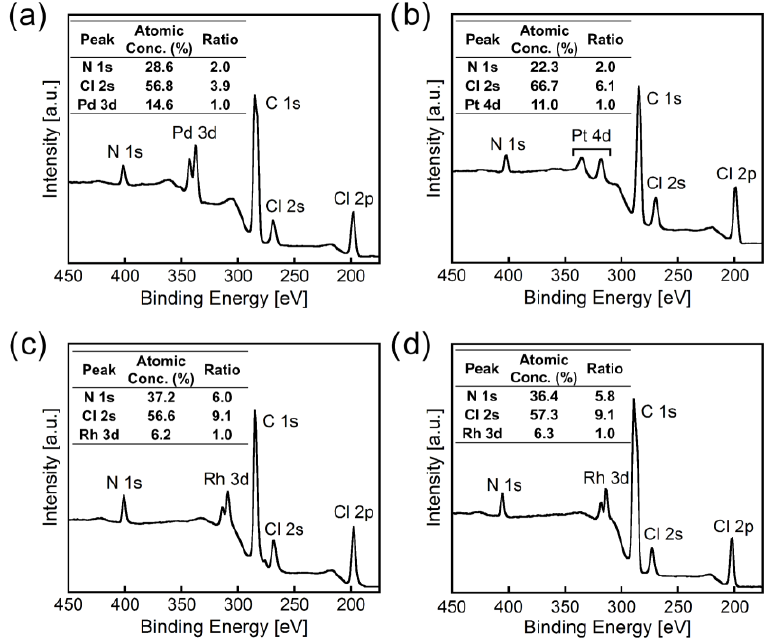
Figure 5. XPS spectra of the precipitates of ( a ) Pd(II) with n -nonylamine, ( b ) Pt(IV) with n -octylamine, and ( c ) Rh(III) with n -octylamine prepared from 6.0 M HCl solutions, and ( d ) the precipitate of Rh(III) with n -octylamine prepared from a 2.0 M HCl solution.